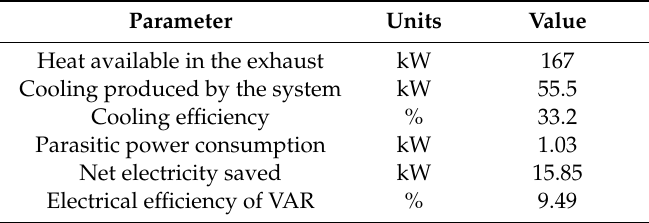
Table 13. Aspen Plus simulation results of heat recovery system using VAR.